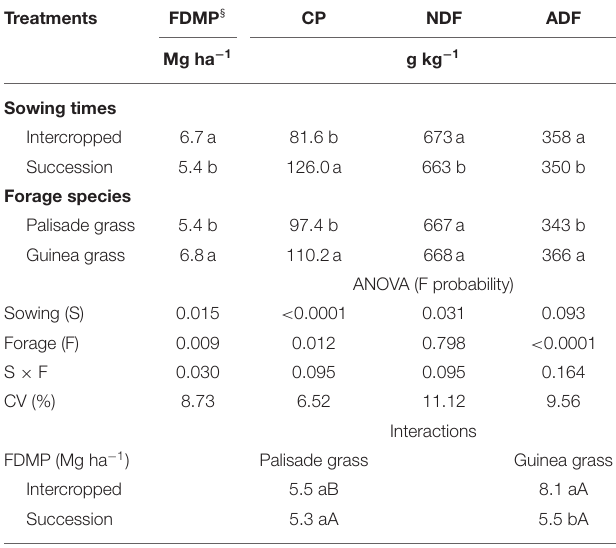
TABLE 2 | Forage dry matter production (FDMP), crude protein (CP), neutral detergent fiber (NDF), and acid detergent fiber (ADF) as a function of sowing times and forage species.